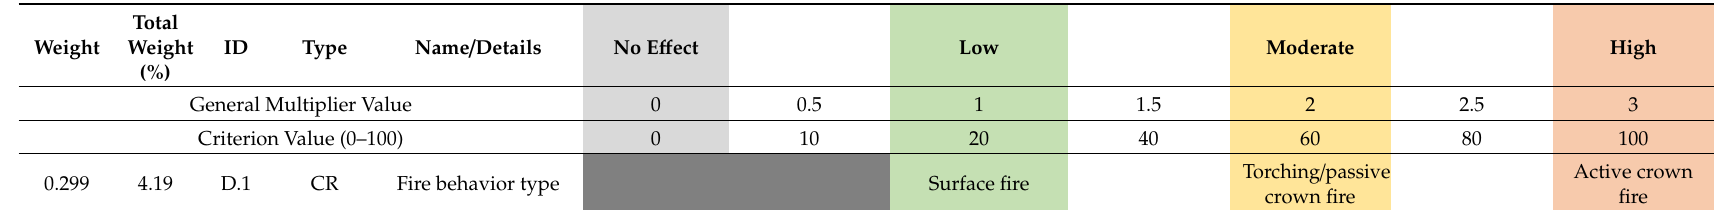
Table A4. Criteria, choices, and weights for the firefighting and wildfire suppression fire e ff ects category. CR: criterion; GM: general multiplier. Light gray: Choices with no e ff ect; Dark gray: N / a, denotes a non-applicable or not available selection; Green: Choices with low e ff ect; Yellow: Choices with moderate e ff ect; Red: Choices with high e ff